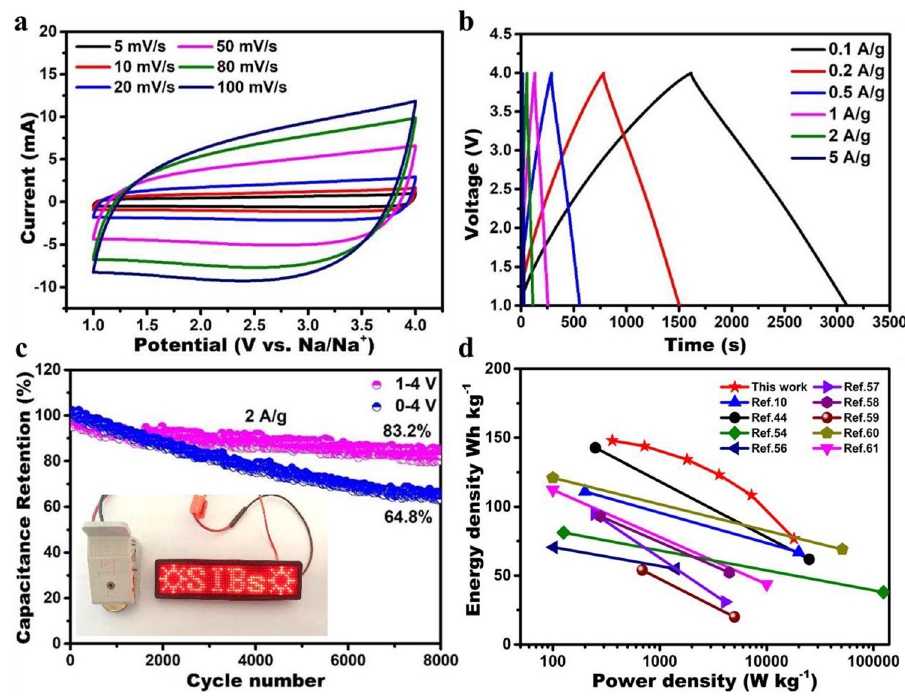
Fig. 6 a CV curves at different scan rates. b Galvanostatic charge/discharge curves. c Long-term cycle performance of TiO 2 /C-HPD3//NPC SICs. d Ragone plots of this work compared with the reported